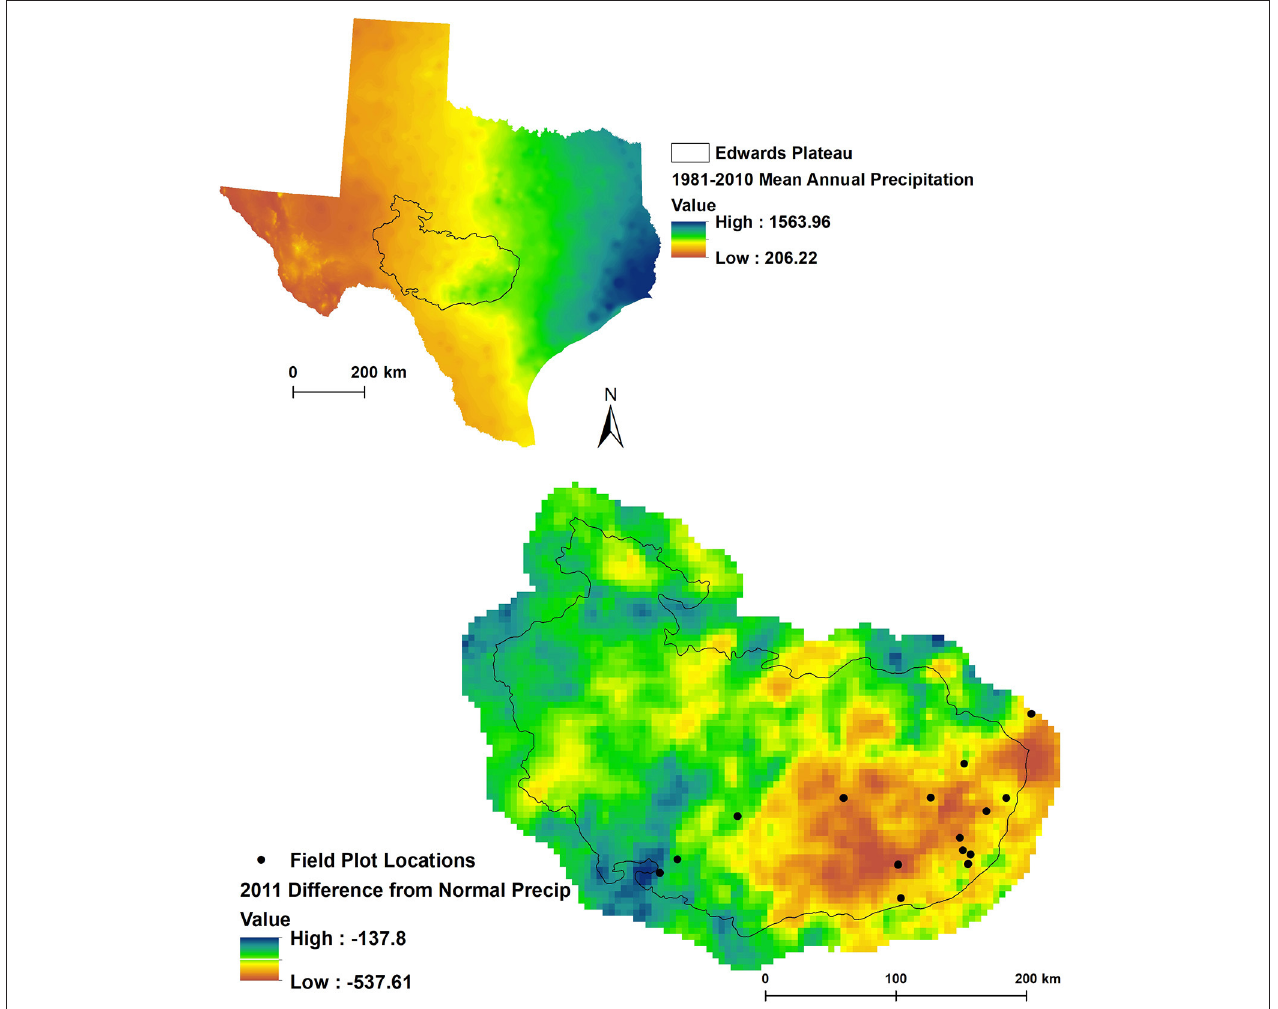
FIGURE 1 | Site locations on the Edwards plateau. The top graph highlights long-term average annual precipitation and the location of the Edwards Plateau in Texas. The bottom graph highlights deviations from average precipitation in 2011 and the study site locations. One site (two plots) falls outside of the Edwards Plateau bioregion but was included in the analysis based on species composition (Ashe juniper